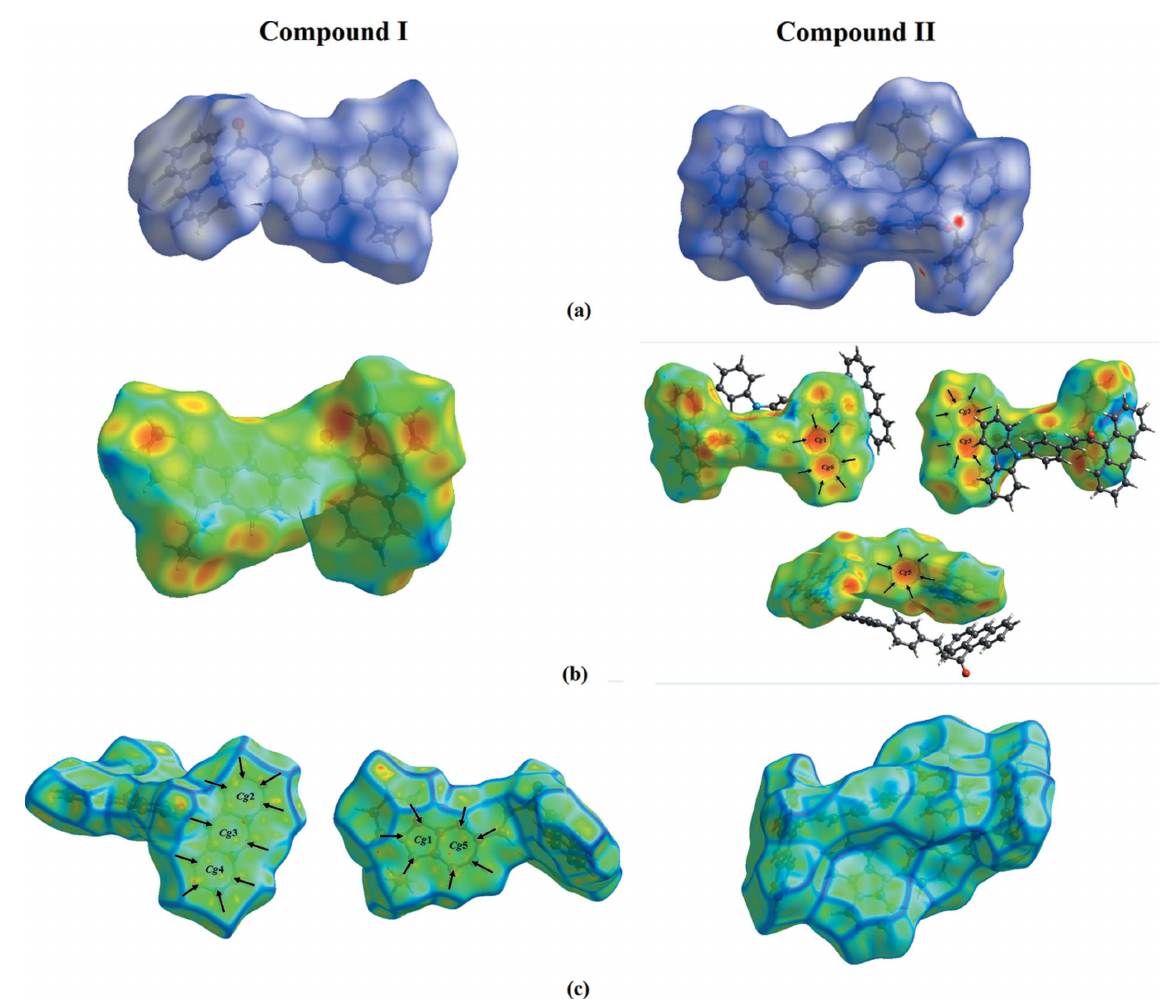
Figure 5 View of the Hirshfeld surfaces for the title compounds, showing ( a ) d norm with the red spots showing the involvement of the C—H (cid:2)(cid:2)(cid:2) O interactions in II , ( b ) mapped over d e with the pale-orange spots within the black arrows indicating the C—H (cid:2)(cid:2)(cid:2) (cid:2) interactions in II and ( c ) mapped over curvedness with the black arrows indicating the (cid:2) – (cid:2) interactions in I .